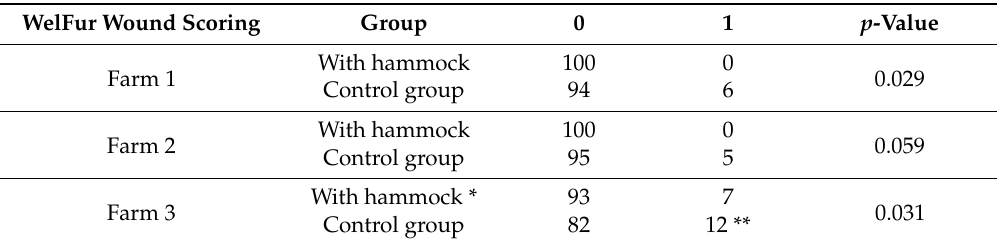
Table 1. Number of developed tail tip lesions per group on Farms 1–3. The scoring is according to the WelFur protocol